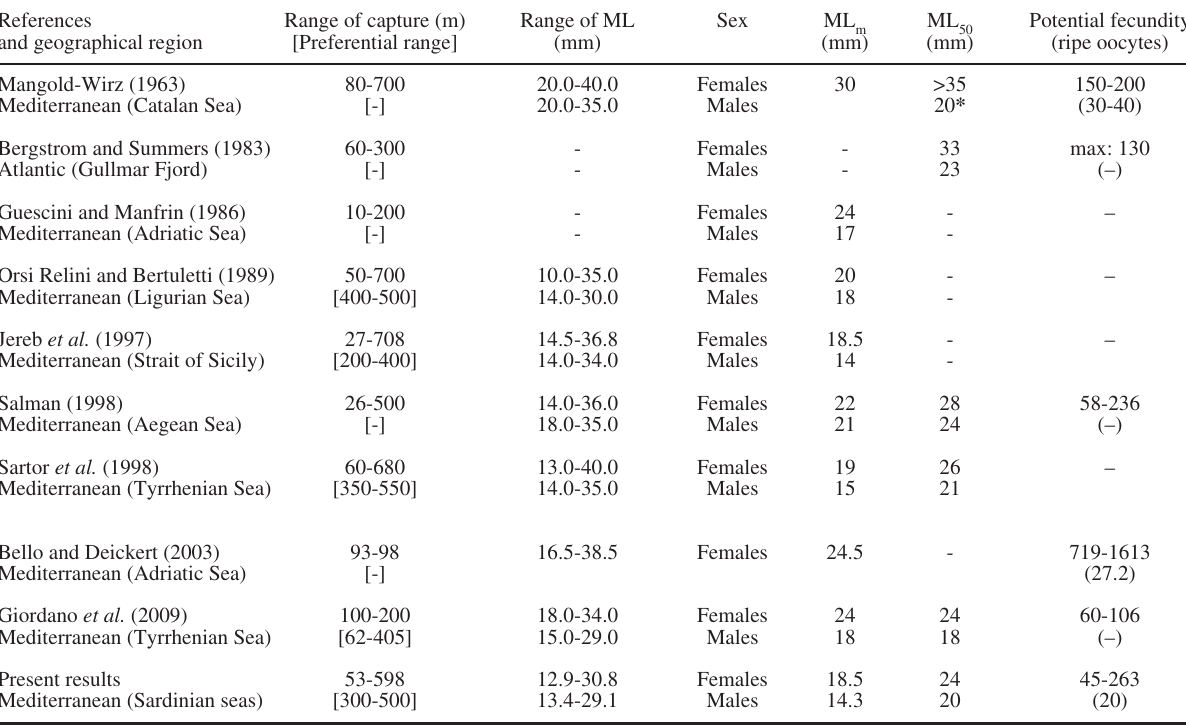
Table 3. – Sepietta oweniana : data on bathymetric distribution, sexual maturity for both sexes and female potential fecundity as available from the literature. ML , mantle length of the smallest mature specimens; ML m